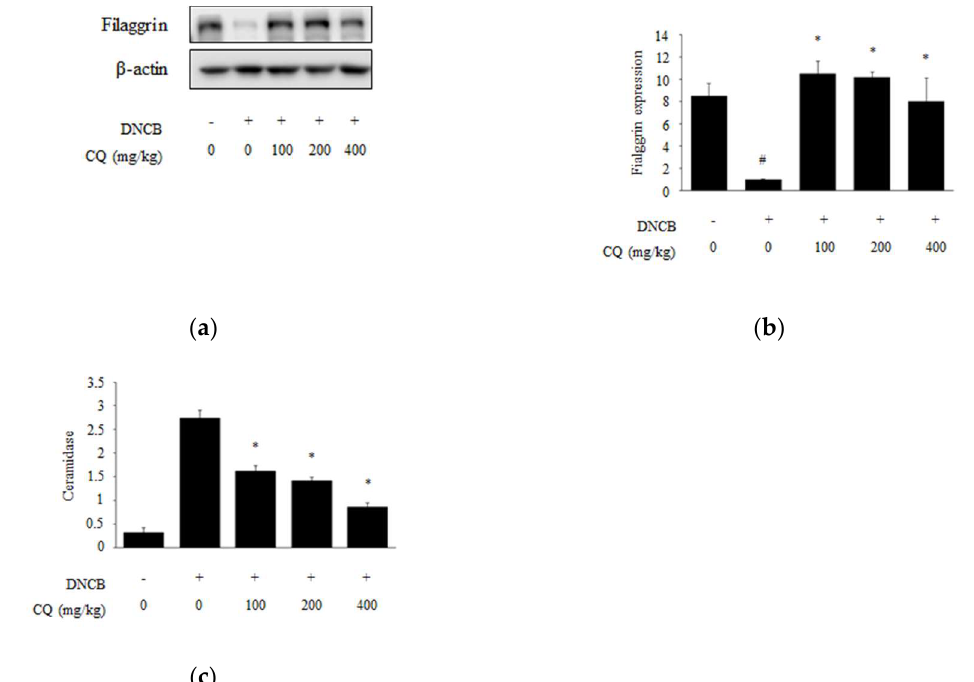
skin lesions. ( a, b ) To observe epidermal thickness, dorsal skin section was stained with H&E and taken using a light microscope at ×100 magnification (scale bar = 100 μm); ( c, d ) To observe mast cell infiltration, dorsal skin section was stained with TB and taken using a light microscope at ×100 magnification (scale bar = 100 μm). All data are presented as mean ± SD; * p < 0.05 vs. DNCB-induced group.